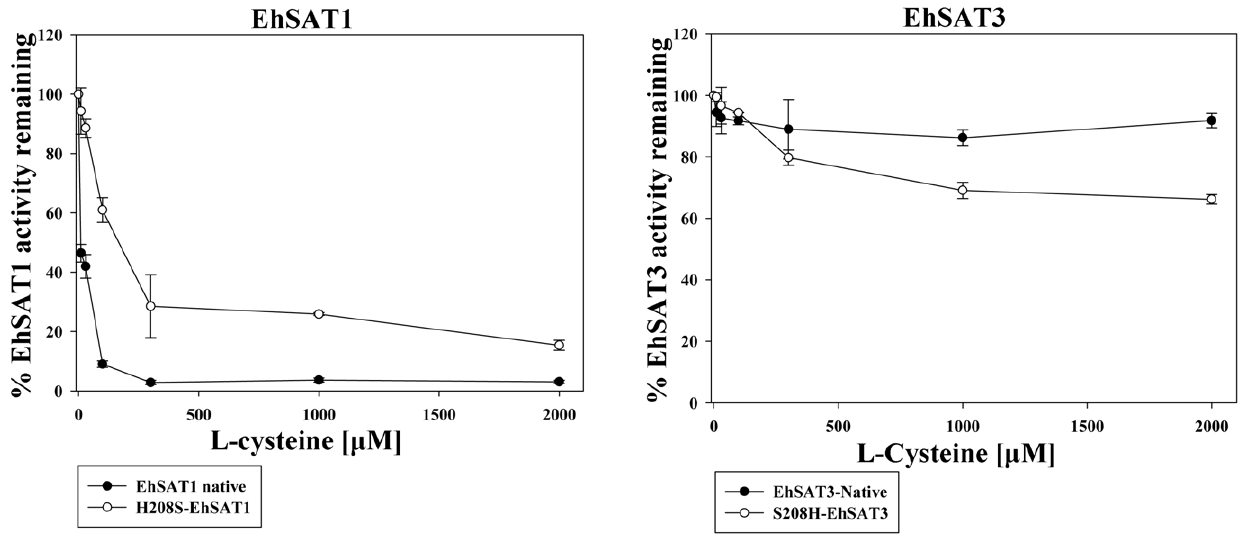
Figure 7. The percent of SAT activity remaining in the presence of increasing concentrations of cysteine. Reactions were carried out in the presence of 3 mM serine. Native EhSAT1 was inhibited completely by 0.1 mM cysteine while the H208S-EhSAT1 mutant was inhibited by only about 85% even at a concentration of 2 mM Cys. As expected, native EhSAT3 was not inhibited by cysteine but the S208H-EHSAT3 showed about 36%